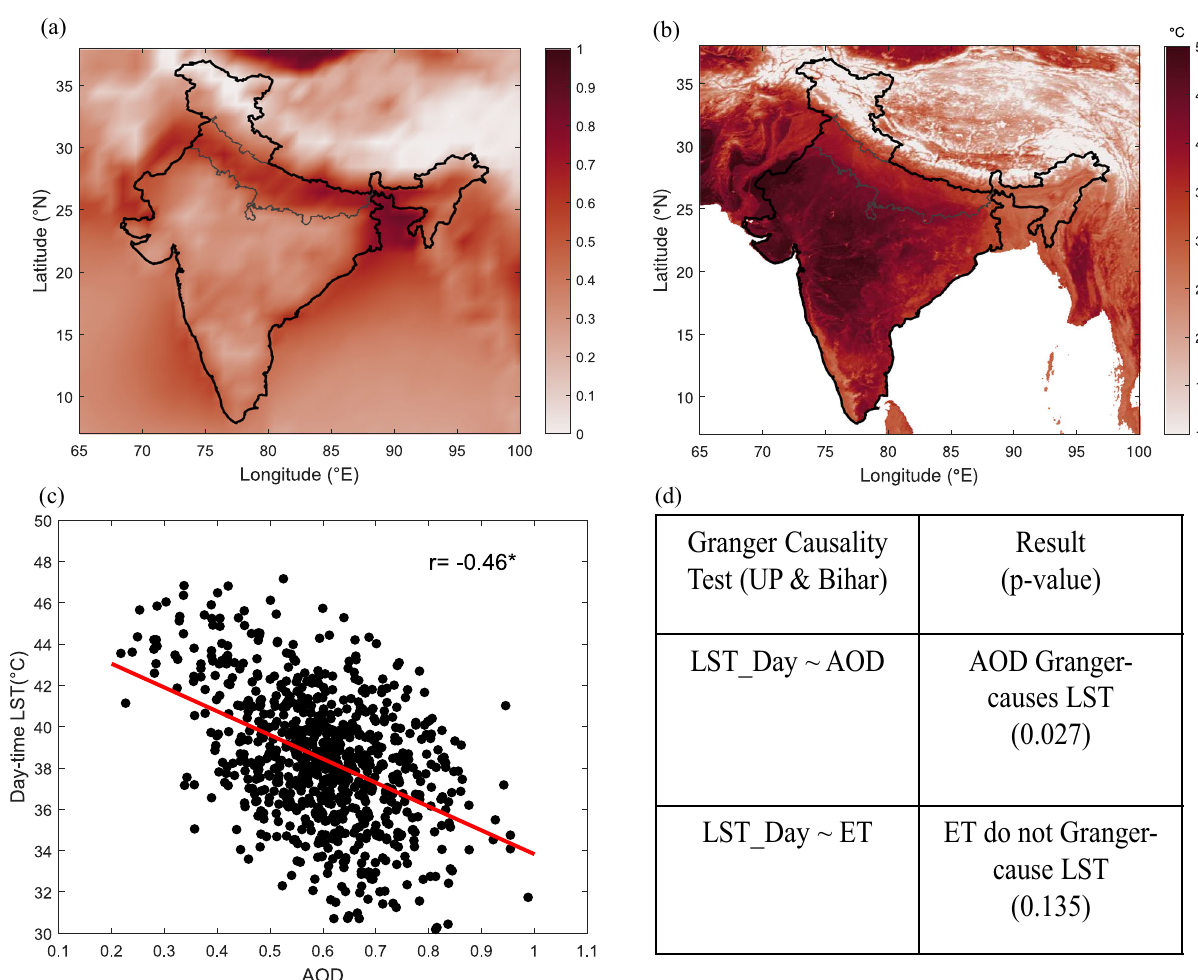
Fig. 4 Relationship between MODIS aerosol optical depth (AOD) and MODIS daytime LST (°C). Seasonal mean (April – May) during the period 2001 – 2020 for a AOD, b Daytime LST, c Scatter plot with Pearson ’ s correlation coef fi cient ( r ) for the Indo-Gangetic Plain. d Causal relationship between variables for Uttar Pradesh (UP) and Bihar: aerosol optical depth (AOD), evapotranspiration (ET) and daytime land surface temperature (LST) from MODIS using Granger causality test in vector auto-regression model (VAR) framework. The null hypothesis for the test is that lagged Variable1 do not explain the variation in